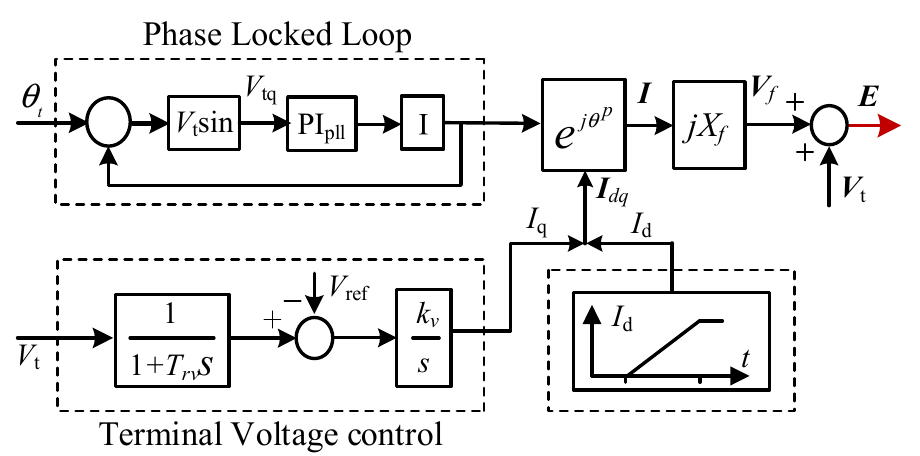
Figure 3. Dynamics of internal voltage in stage I.